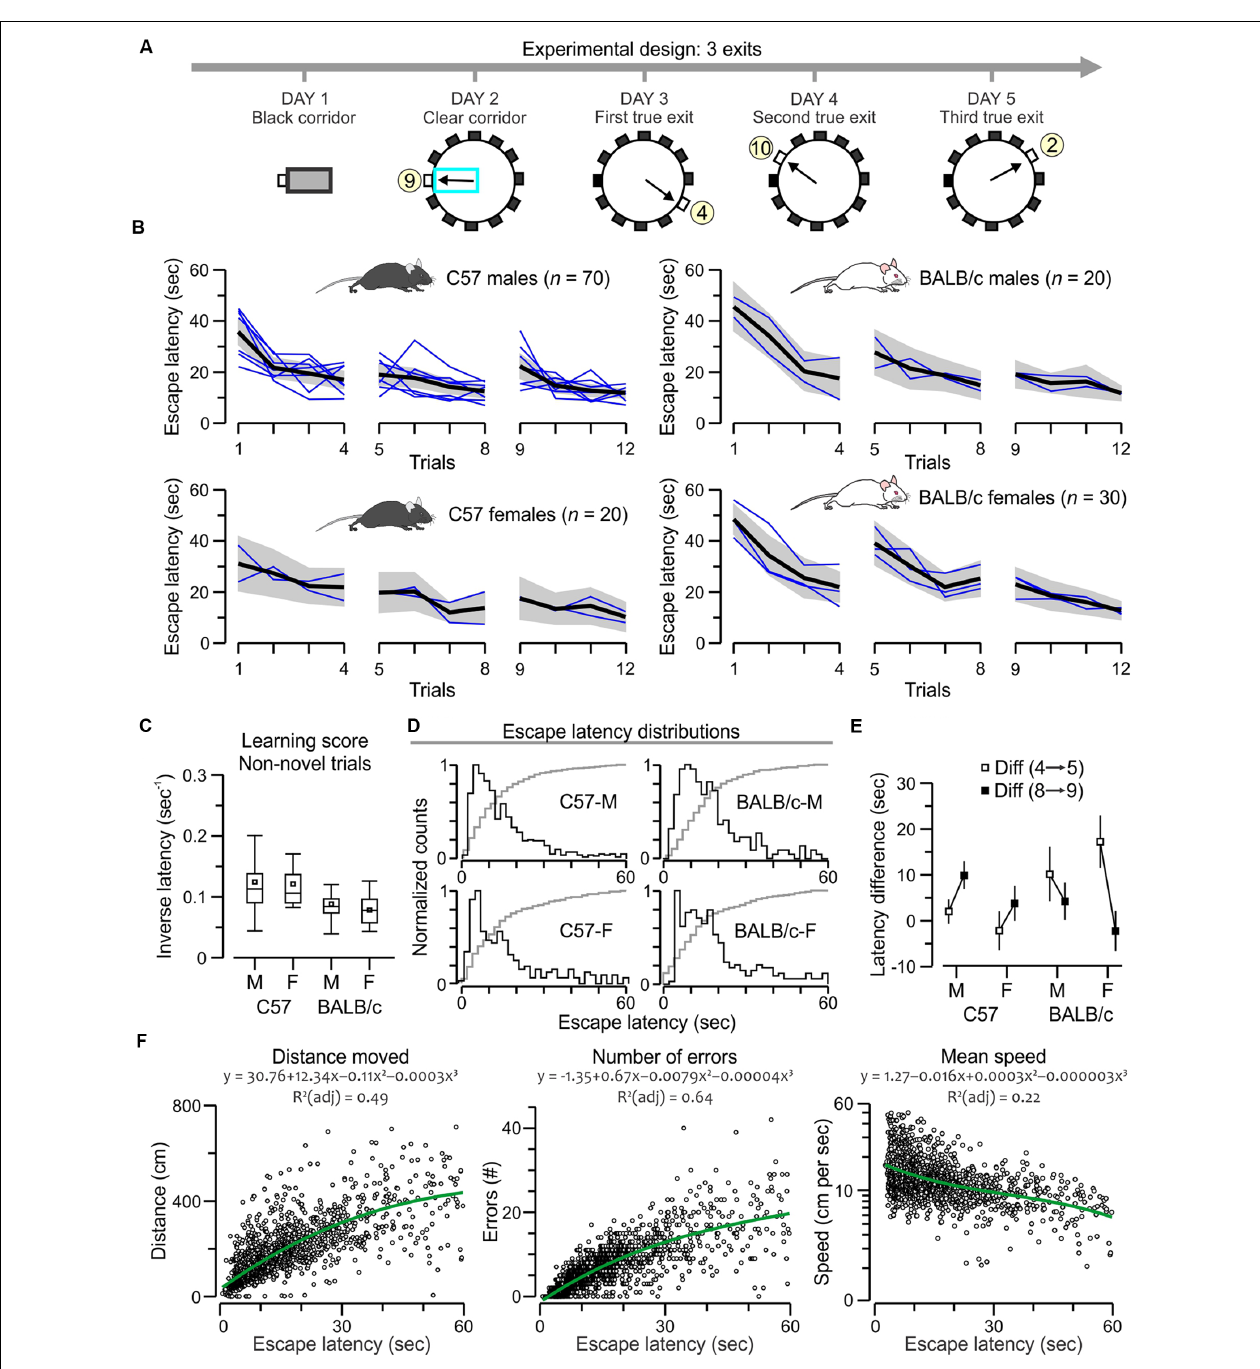
FIGURE 3 | C57 and BALB/c mice show comparable acquisition of the many-exits test. (A) Experimental design of the task, showing plan views of the apparatus with a different true exit for each acquisition day. (B) Plots of escape latency across trials for C57 and BALB/c groups. The black lines denote the ensemble means for the time series, the gray areas are the 5%–95% range, and the blue lines are means for the each separately tested cohort ( n = 10). Both strains learn the task comparably; F > 3, P < 0.0001, RMANOVA (exact values in “ Results ” section). (C) Boxplot of learning scores for non-novel trials (2, 3, 4, 6, 7, 8, 10, 11, 12) showing similar scores for all groups ( P > 0.05 for all t -tests). (D) Histograms of escape latencies (black lines) for successful trials that lasted less than 60 s. The gray lines are cumulative probabilities. (E) Plot of latency difference between trials with a new exit vs. the immediately previous trials (5–4, 9–8) showing positive values for all transitions, suggesting that all mice react to a novel exit. Notably, C57 groups increase the difference values from the first to the second transition (strong novelty effect), whereas BALB/c mice decrease the difference values suggesting a different approach to novelty in this task. (F) Scatterplots showing a correlation of escape latency ( n = 1,513 trials that lasted less than 60 s) with distance moved, number of errors and mean speed (plotted in log scale). Green lines represent polynomial fits for the datasets, which are described by the corresponding functions.